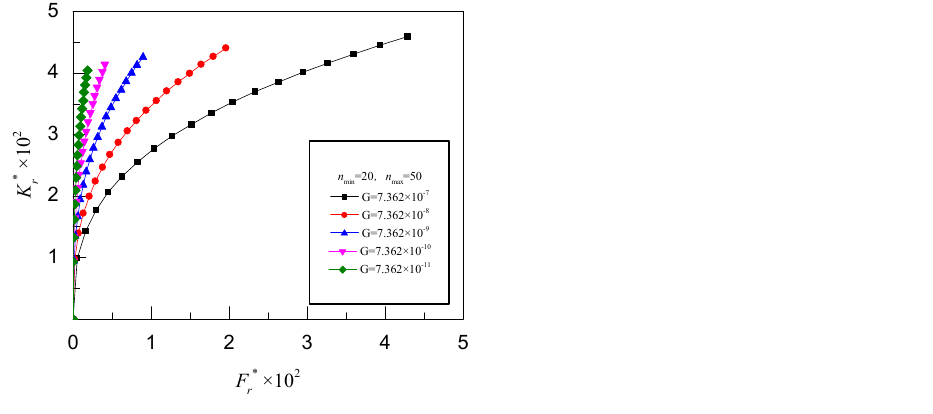
K and characteristic length scale r